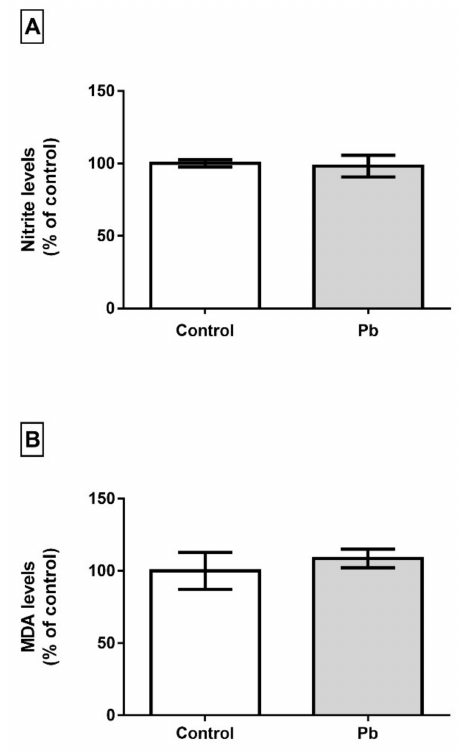
Figure 7. E ff ects of long-term exposure to Pb in synaptophysin (SYP) immunostaining (blue arrowhead) in cerebellum of Wistar rats. ( A ) Control group and ( B ) Lead group. The results are expressed as mean ± standard error of ( C ) area fraction percentage of immunostaining. * p < 0.05 compared to control group (Mann-Whitney test). Scale bars: 20 µ m.